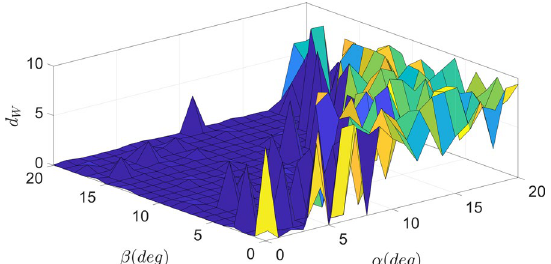
Fig. 20 Wang “ d W ” parameter